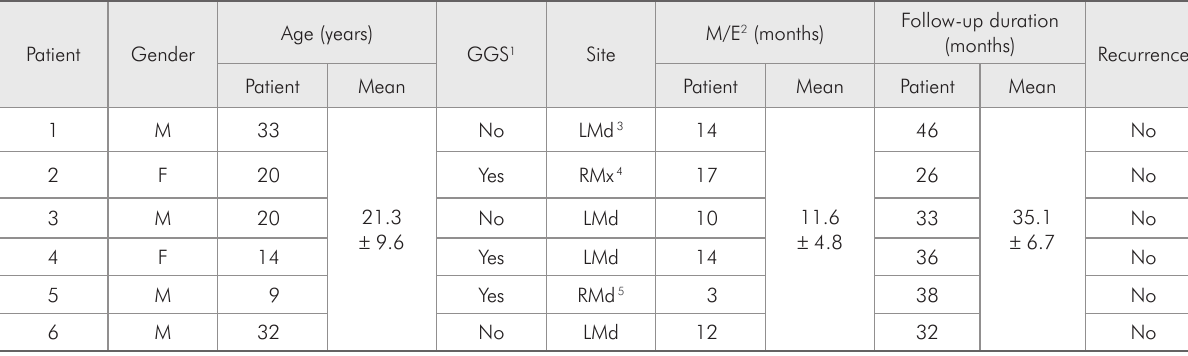
Table 1 - Patient data and clinical features of KOTs (n =